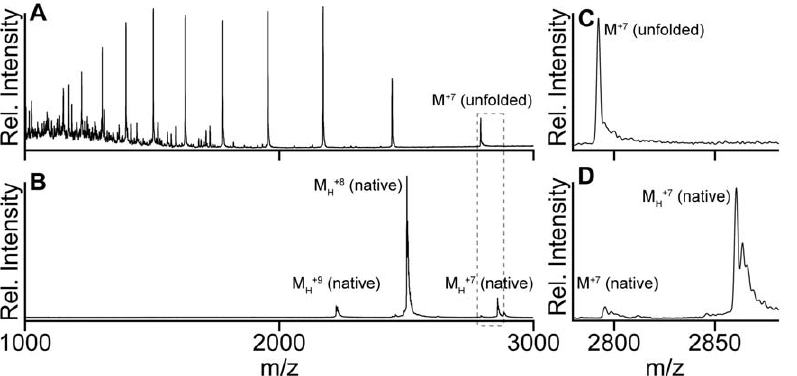
Figure 6. LC-MS and native MS spectra of flavodoxin. (A) LC-MS spectrum of flavodoxin. (B) Nano-electrospray mass spectrum of flavodoxin. M H + n represents flavodoxin monomer with n positive charges, and M + n is apoflavodoxin monomer with n positive charges. (C and D) Spectra of area indicated by the grey contour in (A) and (B), respectively. Flavodoxin (5 m M) is in 50 mM ammonium acetate, 0.1 mM EDTA, pH